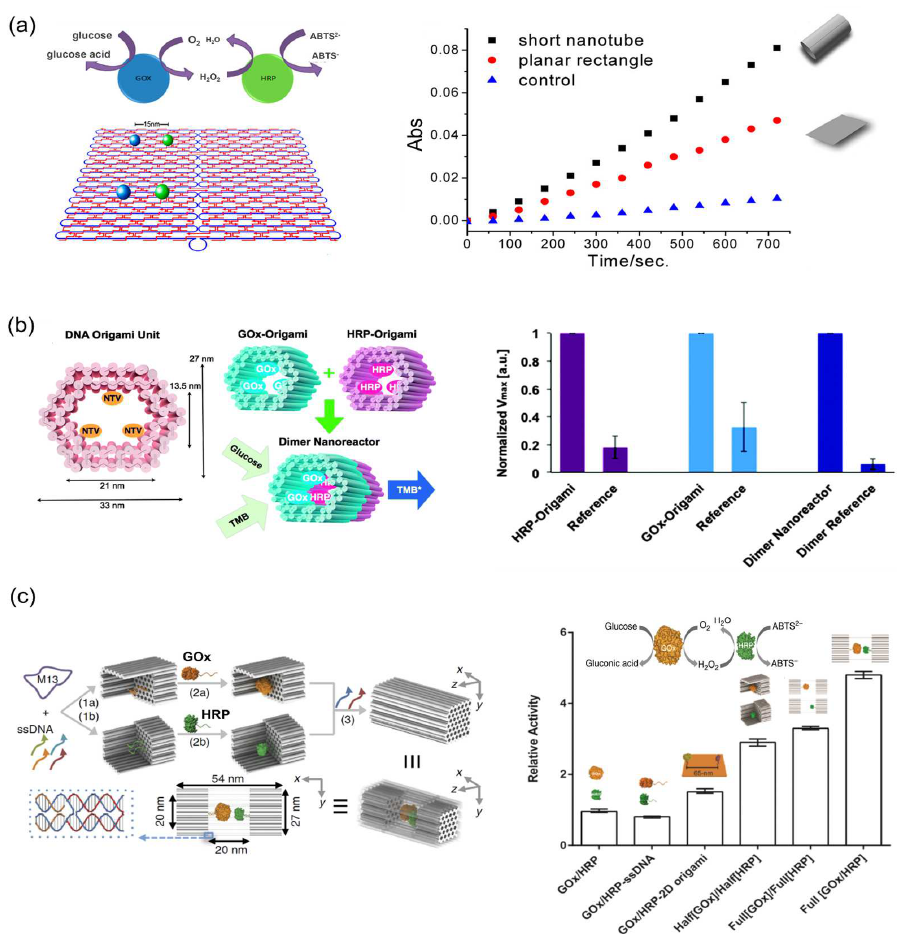
Figure 14. Enzyme cascade reactions on the DNA scaffolds with confined environment. ( a ) Illustra- tions of glucose oxidase (GOx) and horseradish peroxidase (HRP) assembled on the DNA rectangle or encapsulated in the DNA tube [107]. ( b ) GOx and HRP encapsulated in a DNA tubular struc- ture. Two separately fabricated origami units are equipped with biotinylated GOx or HRP through biotin–avidin interaction. The right panel showed the maximum rate of reactions ( V max ) of enzymes attached to DNA origami units and for the assembled dimer nanoreactor. Dimer reference indicated the dimer origami fabricated similarly but without enzyme binding sites [108]. ( c ) GOx/HRP encap- sulated in a DNA nanocage. Individual enzymes were first attached to half cages, followed by the addition of linker strands to combine the two halves into a full cage. The right panel showed the relative activity of a GOx/HRP pair when attached to a variety of DNA scaffolds: enzyme wild types (GOx/HRP), ssDNA (GOx/HRP-ssDNA), 2D rectangular DNA origami (GOx/HRP-2D origami), separate 3D half cages (Half[GOx]/Half[HRP]), separately full cages (Full[GOx]/Full[HRP]) and the same full cage (Full [GOx/HRP]) [75]. Reprinted with permission from: ( a ) Ref. [107]. Copyright